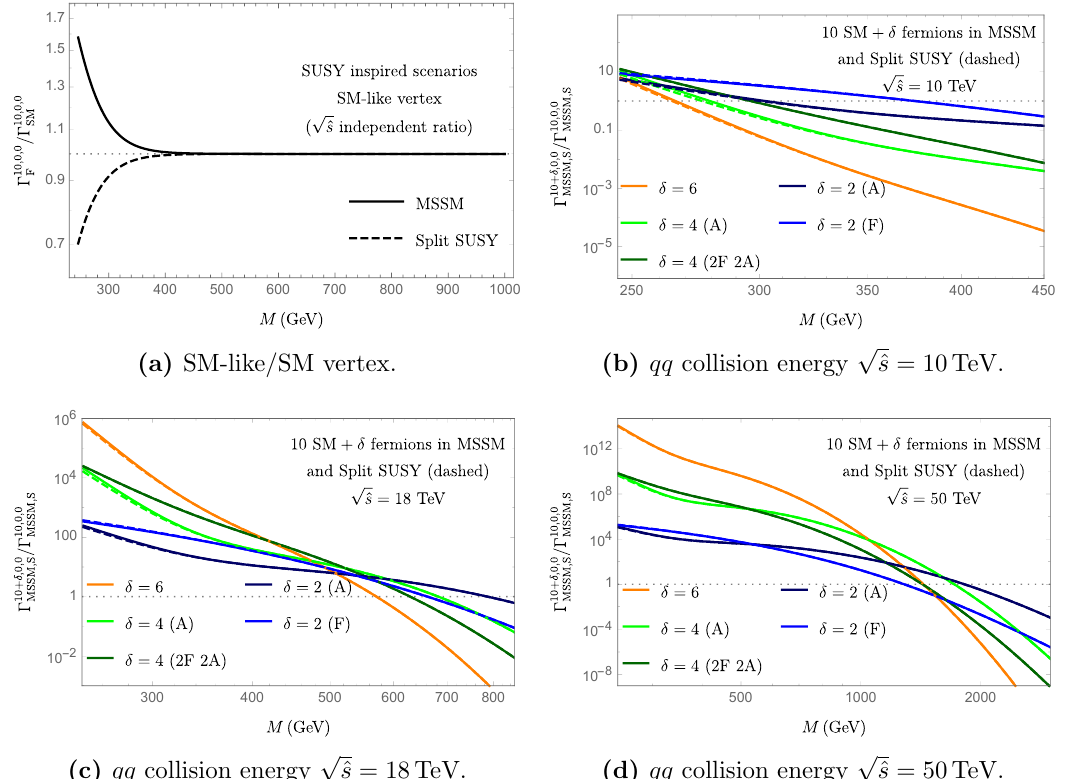
Figure 3. SM-like/SM (upper left) and BSM/SM-like rate ratios in the MSSM and Split SUSY.